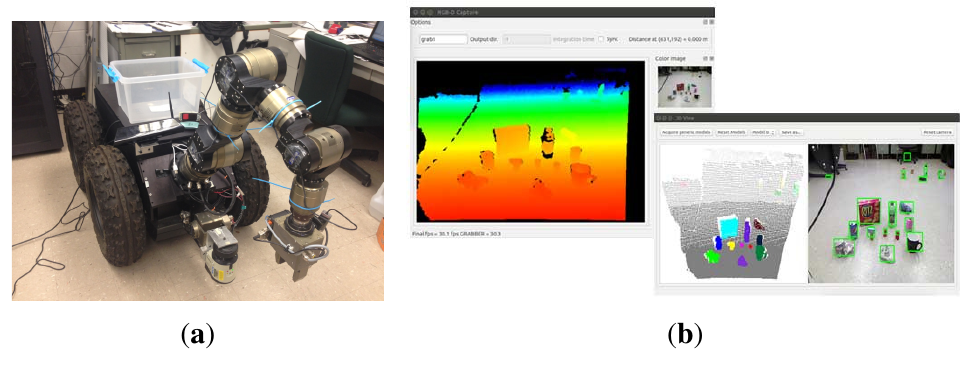
Figure 10. Our mobile manipulator ( a ) and the developed GUI ( b ) for observing the object detection process.